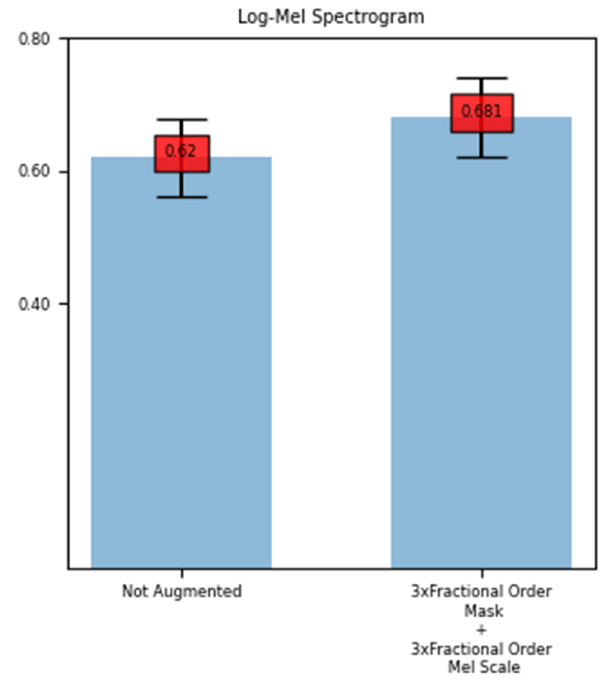
Figure 3. Accuracy scores for ResNet-18